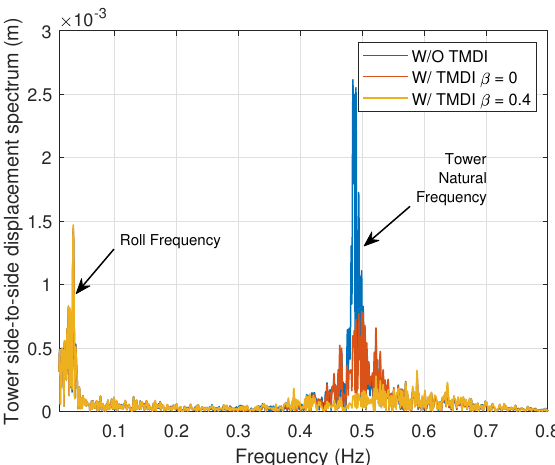
Figure 10. Tower side-to-side displacement spectrum.